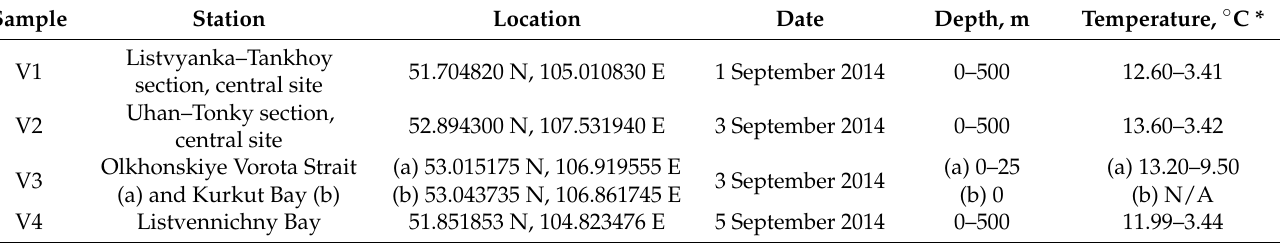
Table 1. Sampling sites and their